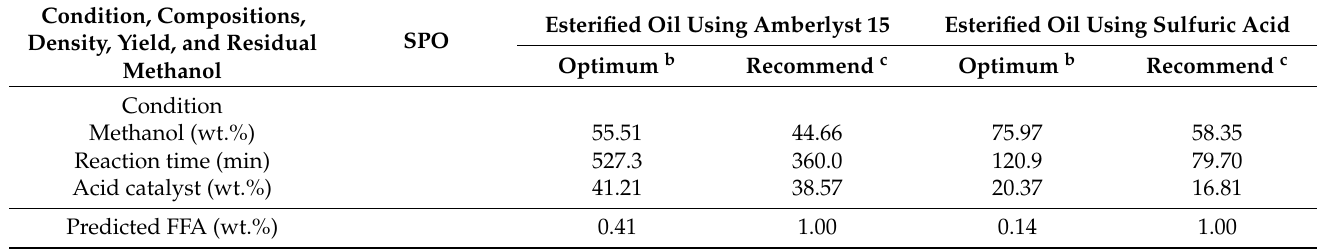
Table 5. Condition, physical property, compositions, density, yield, and residual